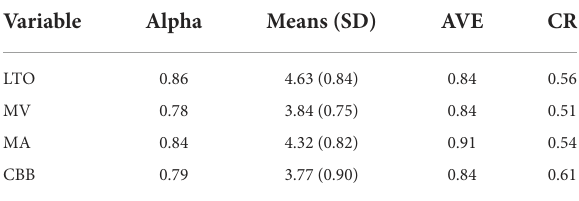
TABLE 3 Scale reliability levels ( α ), means, standard deviations (SD), average variance extracted (AVE), and composite reliabilities (CR) (China